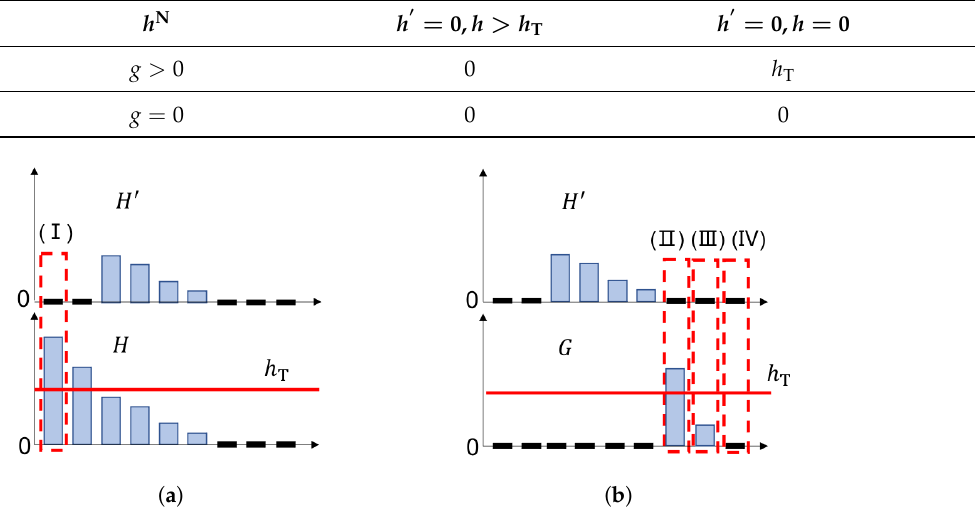
Figure 3. Special cases of zero frequency h (cid:48) = 0 during the inverting process. ( a ) shows the case (I) when h (cid:48) = 0 and h > h T . ( b ) shows the cases (II), (III), and (IV) when h (cid:48) = 0, h = 0 and g > 0 or g = 0.